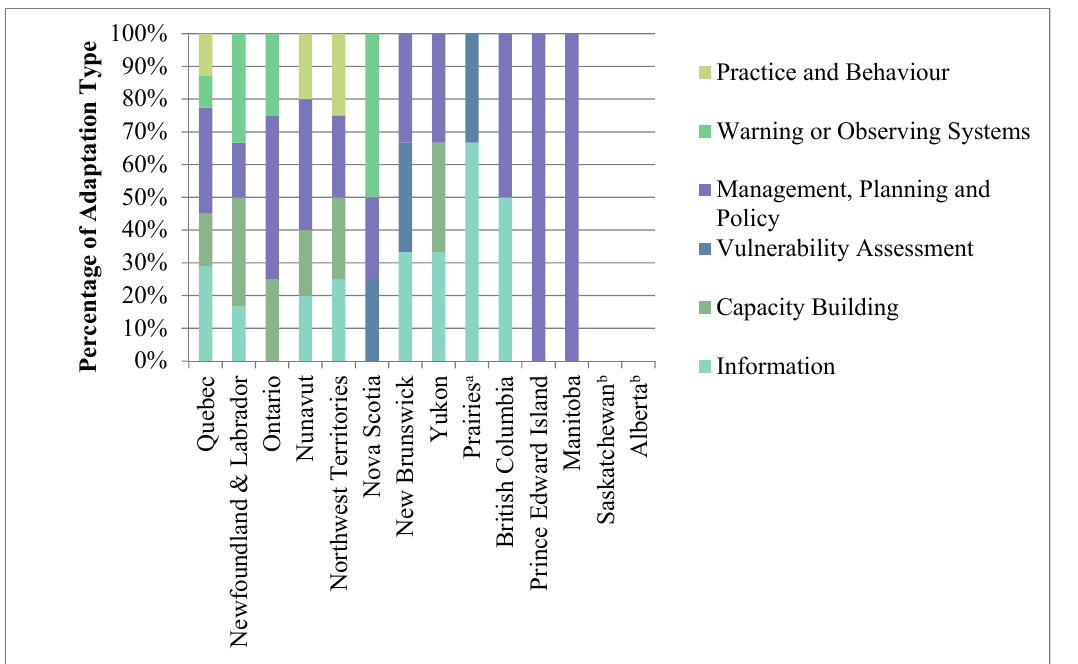
Figure 4. Types of climate change risks addressed by provincial and territorial health adaptation initiatives.